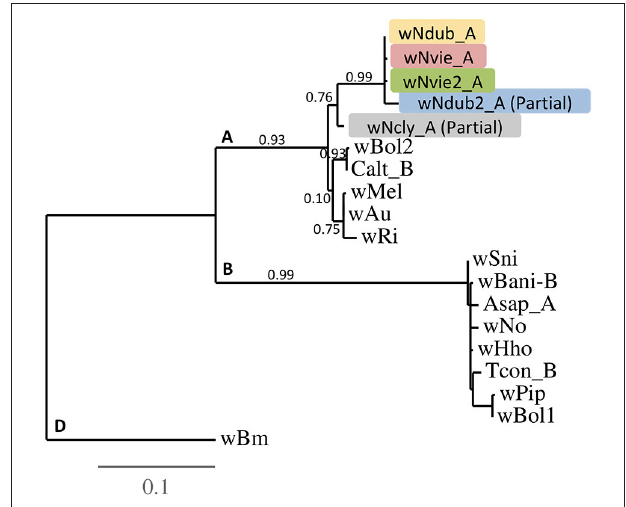
FIGURE 2 | Phylogenetic tree of the five different Wolbachia strains characterized from the N. clypeatus clade, with bootstrap values. Input sequences were concatenated sequences from all five MLST (2,081 bp total), except for the partially characterized strains w Ndub2_A (three MLSTs: 1,249 bp), and w Ncly_A (five MLSTs, with partial hcpA sequence: 1,887 bp) ( Table S1 ). Additional strains from the A-, B-, and D-supergroups were characterized from butterflies ( w Bol1, w Bol2, w Bani_B), fruitflies ( w Ri, w Mel, w Au, w No), mosquitoes ( w Pip), wasps ( w Hho), beetles ( w Sni, Asap_A, Calt_B, Tcon), and nematodes ( w Bm). The D-supergroup w Bm strain was used as the outgroup for the